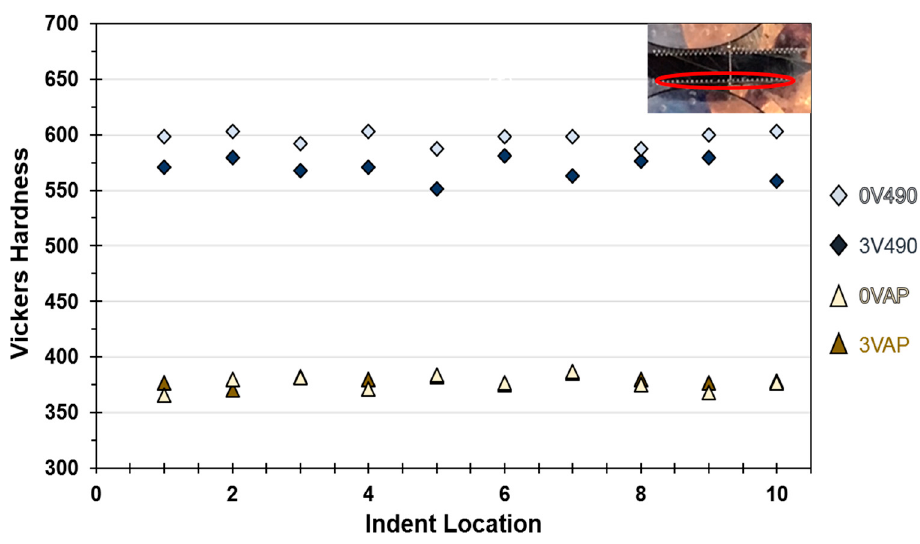
Figure 8. Results of microhardness testing in as ‐ printed and heat ‐ treated V samples, inset indicates indent location.